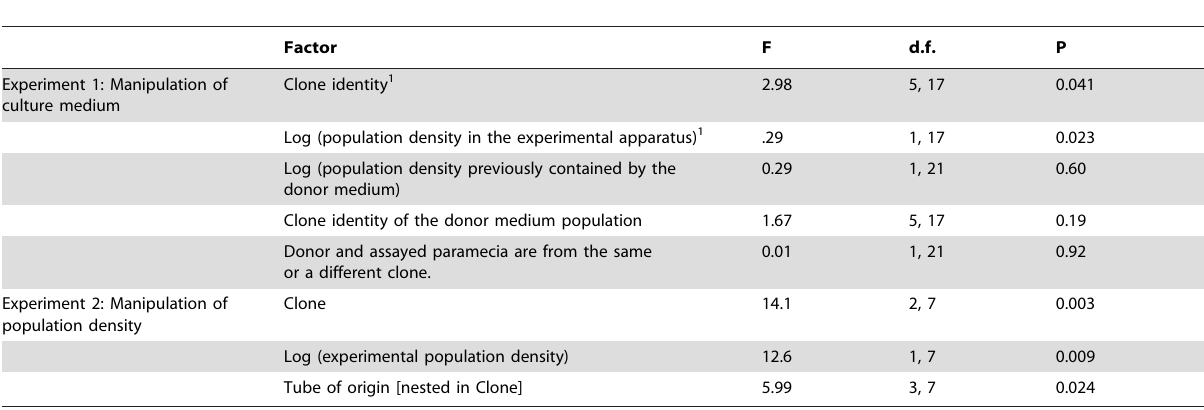
Table 1. Statistical analysis of the proportion of paramecium cells dispersing in experiments 1 and 2.